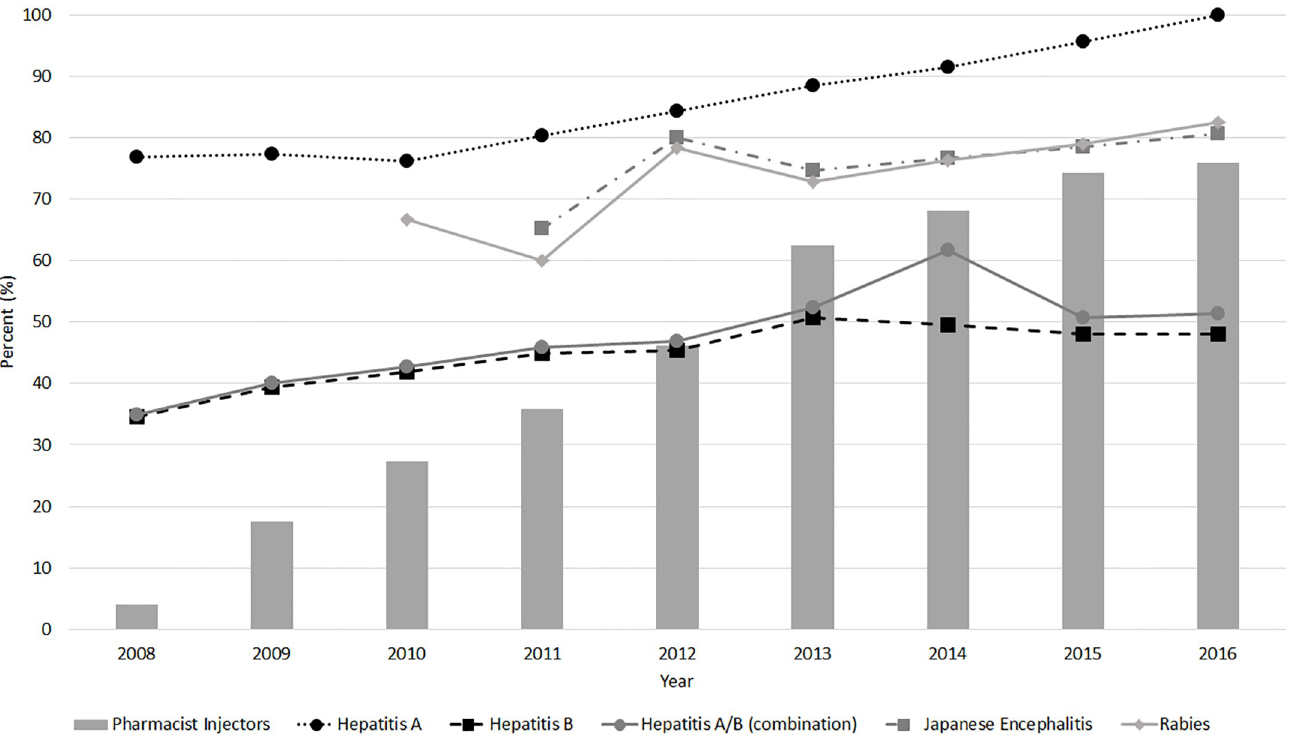
Fig 1. Percentage of pharmacists authorized to administer injections and percentage of series completion per vaccine, per year.